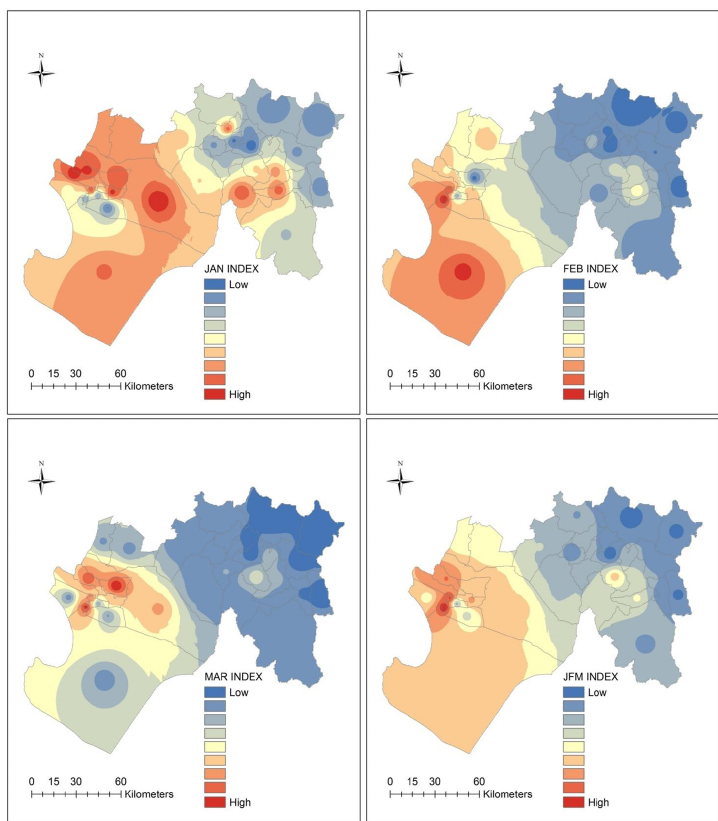
Figure 7. Maps of ecosyndemic index (low — blue to high — red) at the district-level by month and season (JFM), using the inverse-weight distance interpolation method.